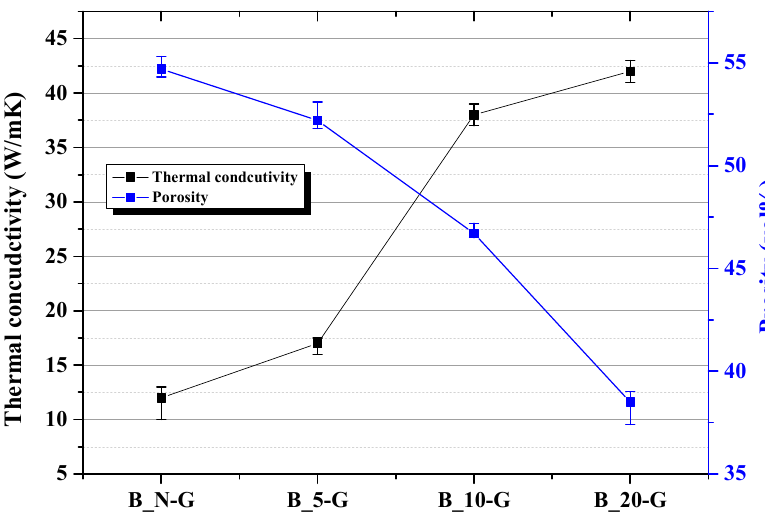
Figure 5. Thermal conductivity and porosity of graphite block.